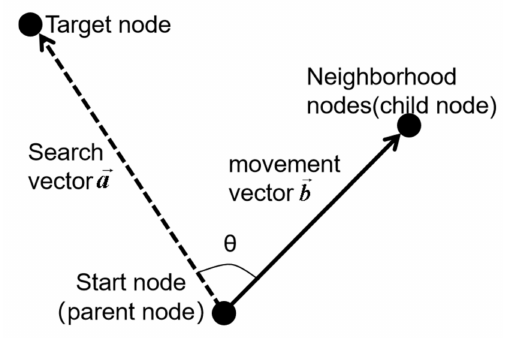
Figure 9. Vector angle